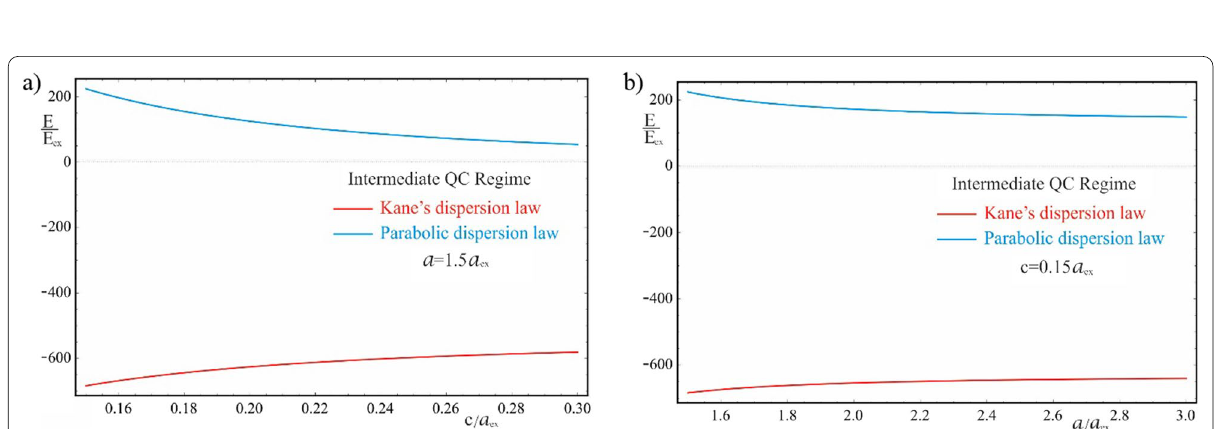
Fig. 10 The dependences of the ground and first excited energy levels of a 2D exciton with parabolic and Kane’s dispersion laws of CCs, respectively, at the intermediate quantum confinement regime: ( a ) on the minor semiaxis c at the fixed value of the major semiaxis a , ( b ) on the major semiaxis a at the fixed value of the minor semiaxis